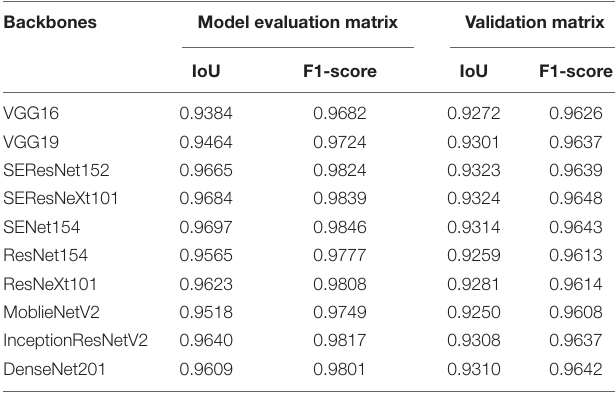
TABLE 2 | Summary of an evaluation matrix for semantic segmentation of U-Net using various deep learning backbones (encoder). Backbones Model evaluation